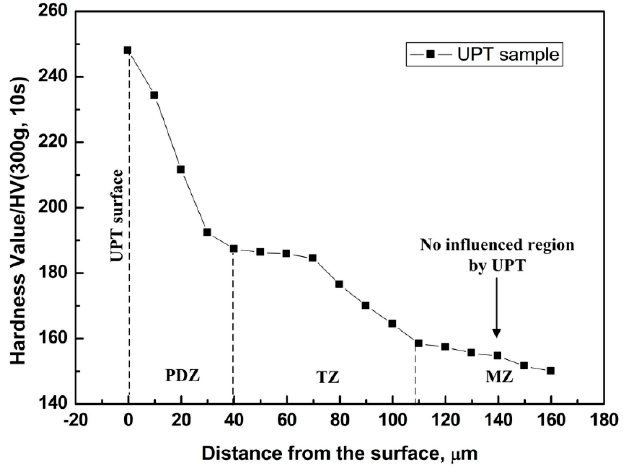
Figure 4. The variation trend of hardness values after UPT from surface to interior.